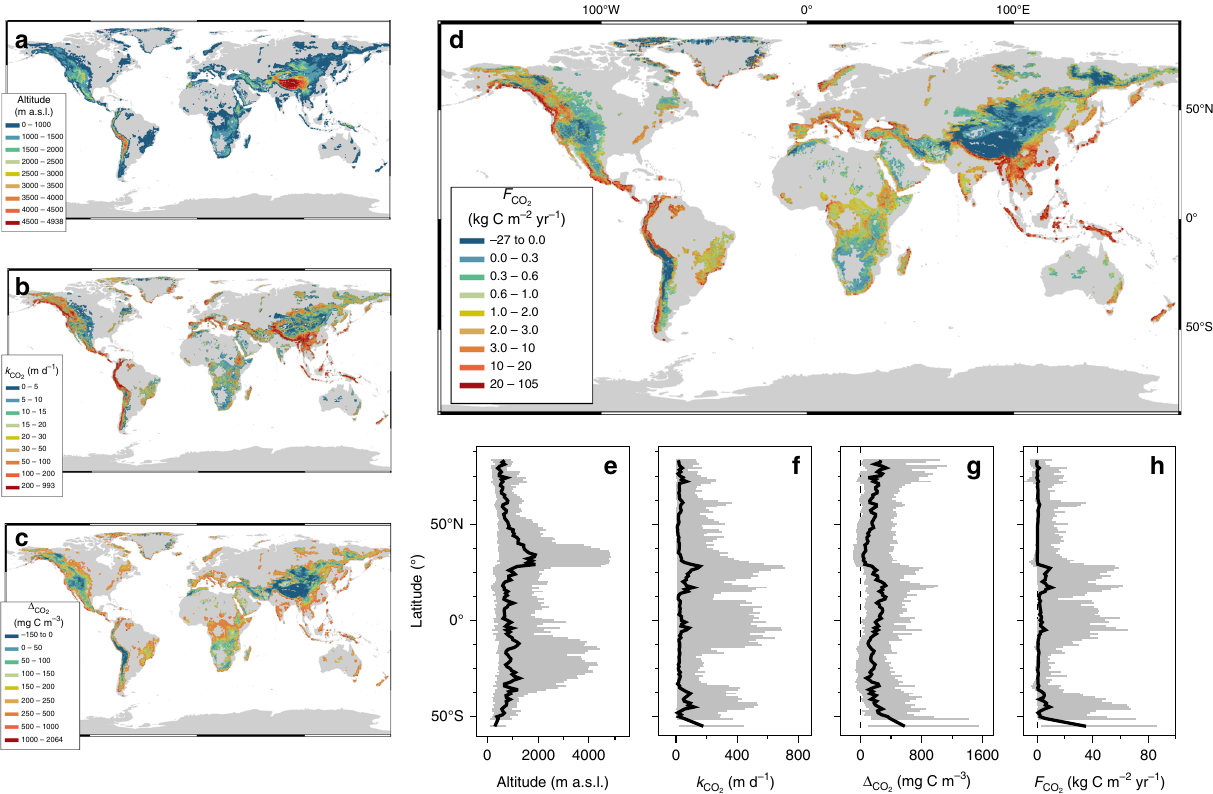
Fig. 3 Global distributions of CO 2 in mountain streams. a Altitude of mountain streams, where mountains as de fi ned according to ref. 7 . b – d Global distribution of predicted CO 2 exchange velocities ( k ), CO 2 gradients between the streamwater and the atmosphere ( Δ CO 2 ) and the areal CO 2 fl uxes CO 2 ( F ), respectively. e – h Latitudinal transects of these same parameters at 1-degree resolution (shown are median values in black and 5 and 95% CO 2 con fi dence intervals in